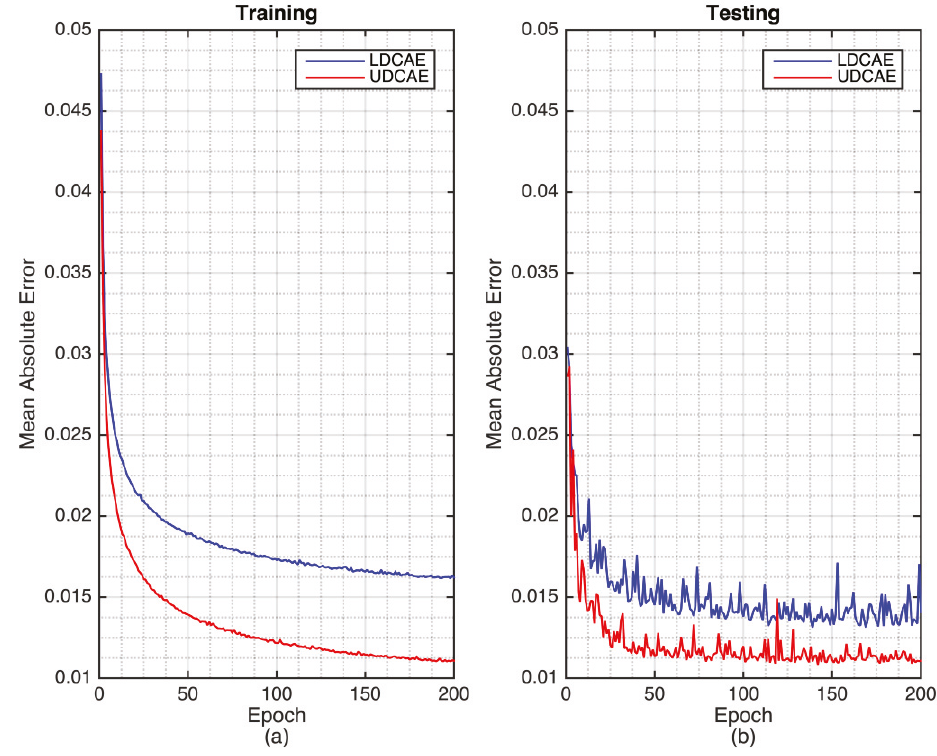
Figure 1. The training ( a ) and testing ( b ) of the LeNet-5 based deep convolution autoencoder (LDCAE) and U-Net-based deep convolutional autoencoder (UDCAE) models.